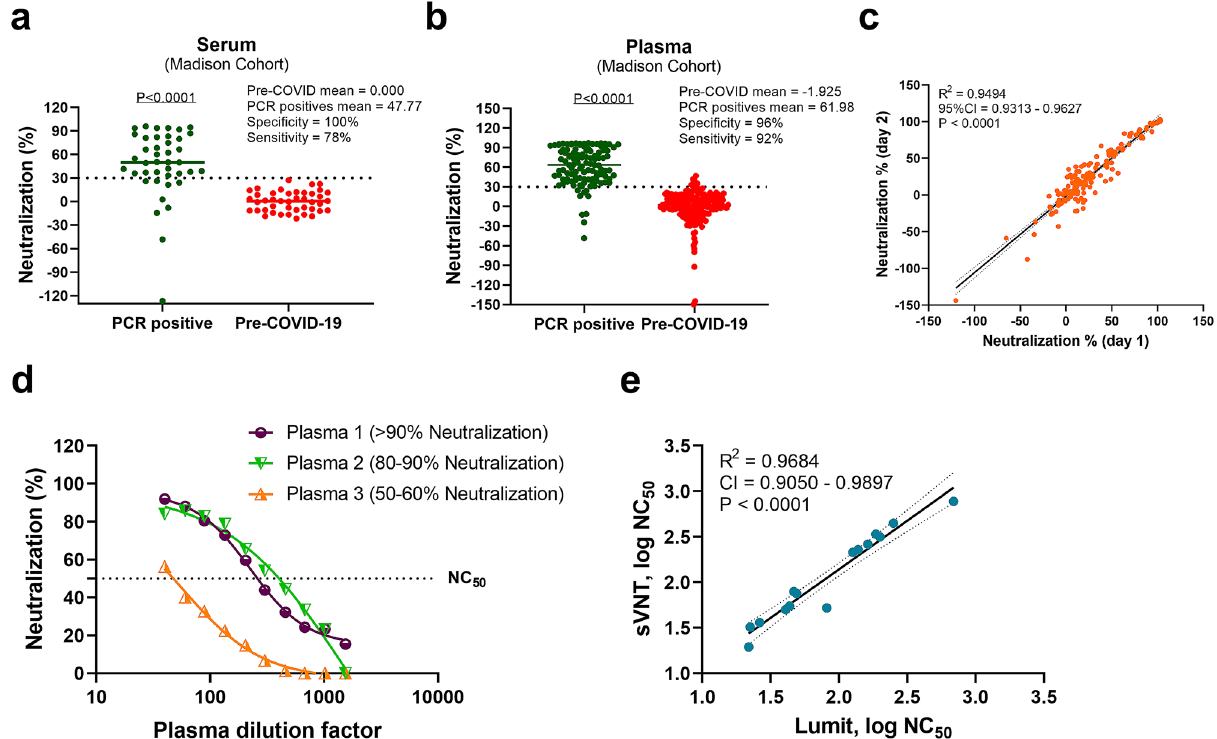
Figure 5. Testing patient derived samples with Lumit SARS-CoV-2 Spike RBD:ACE2 Immunoassay. ( a ) Patient-derived serum samples from 41 COVID-19 positive and 43 negative pre-pandemic samples were tested using Lumit SARS-CoV-2 Spike RBD:ACE2 Immunoassay at 1/20 (5%) final serum dilution. Serum samples were pre-incubated with RBD-Fc for 30 min prior to the addition of the other assay components. ( b ) COVID-19 positive (n = 116) and negative pre-pandemic (n = 202) plasma samples were tested at 1/20 final plasma dilution. A cutoff value of 30% was selected based on the distribution of COVID-19 positive and negative pre-pandemic samples and the assay improved specificity. The horizontal lines indicate the mean values, and the dotted lines represent the cutoff at 30% inhibition. The P values presented in ( a ) and ( b ) were calculated from unpaired two- tailed Student’s t tests. ( c ) Assay robustness. COVID-19 positive (n = 58) and negative pre-pandemic (n = 101) plasma samples were tested on two different dates. ( d ) COVID-19 positive plasma samples with varying percent neutralization values were titrated to determine the NC 50 values. ( e ) Correlation analysis of Lumit Spike RBD:ACE2 Immunoassay with an in vitro surrogate viral neutralization assay (sVNT). Serially diluted plasma samples with percent neutralization values ranging from 50 to 90% at 1/20 final plasma dilution were tested with both Lumit and the sVNT (c-Pass), and NC 50 values were determined and compared. The data presented are the log of the IC 50 values for sVNT and Lumit and are the mean from two independent experiments. Correlation and linear regression analyses in c and e were performed in GraphPad Prism using Pearson’s correlation coefficients. Statistical significance was calculated using the two-tailed